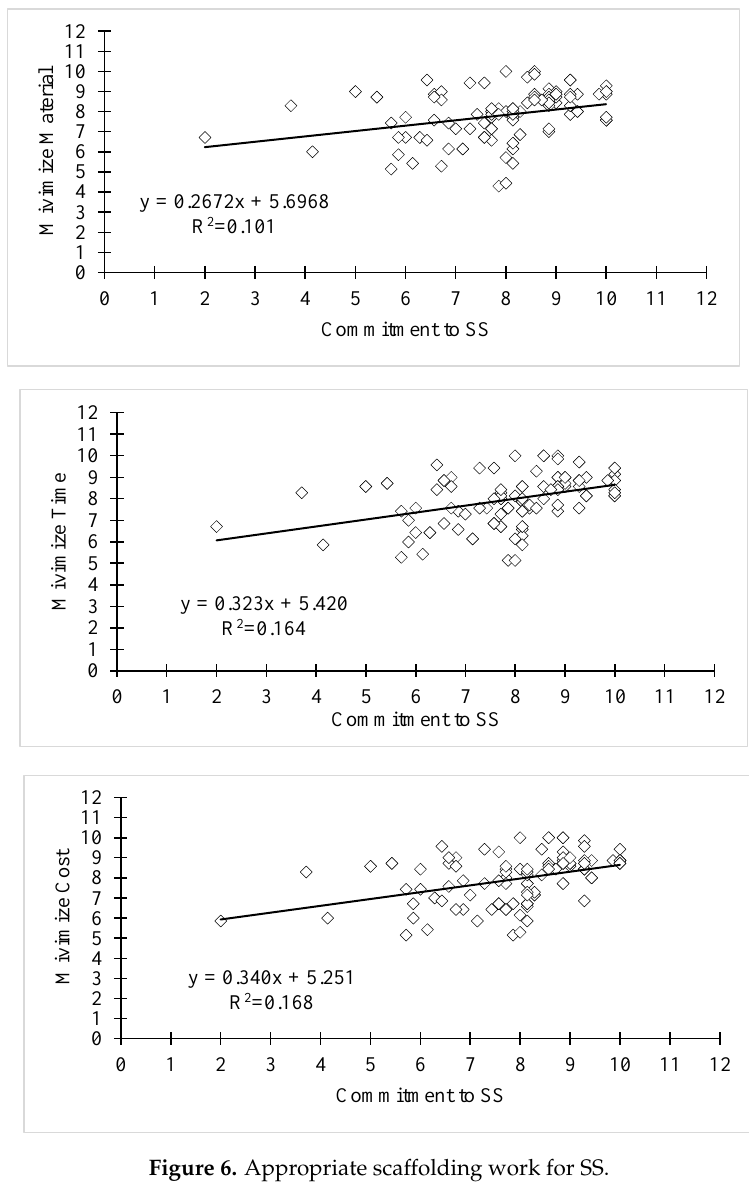
Figure 6. Appropriate scaffolding work for SS.